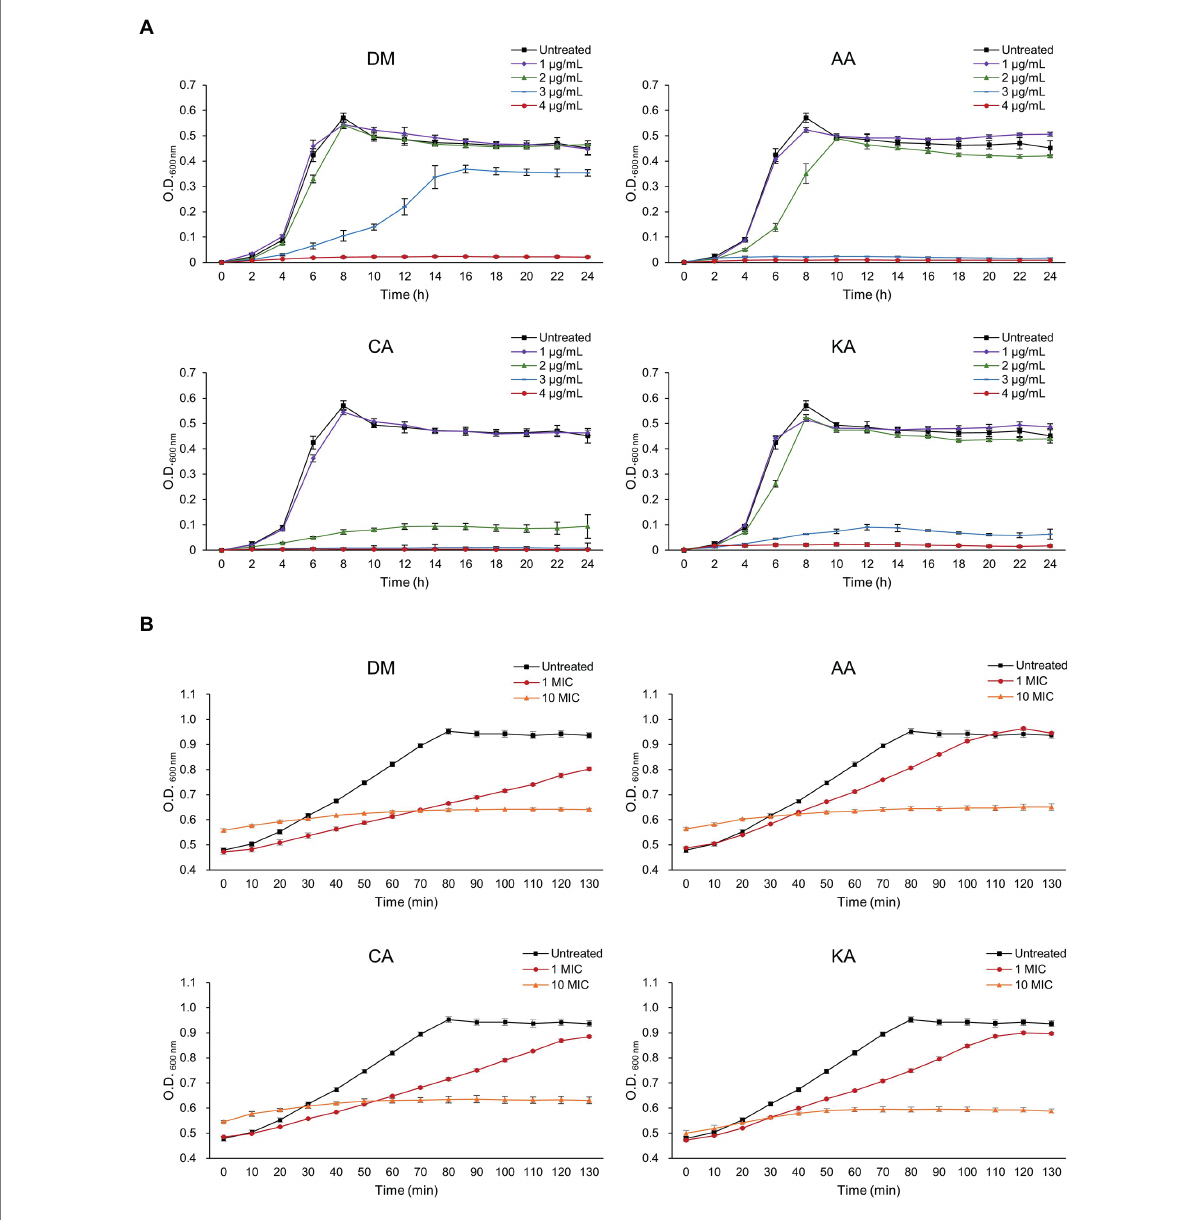
FIGURE 2 The effect of diterpenoids on the growth of S. mutans . Diterpenoids were added to the bacteria in (A) the lag phase and (B) the mid exponential